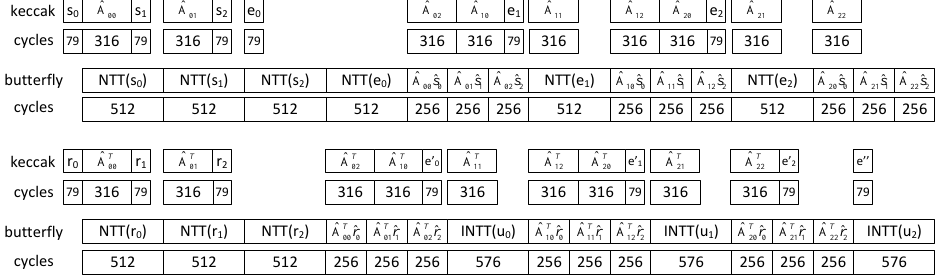
Figure 9: Elaborate scheduling during sampling and corresponding NTT procedures be set as 24 × 512 data storage, in order to fully save ˆ t when k takes 4. Similarly, DFIFO1 should be set as 10 × 128 data